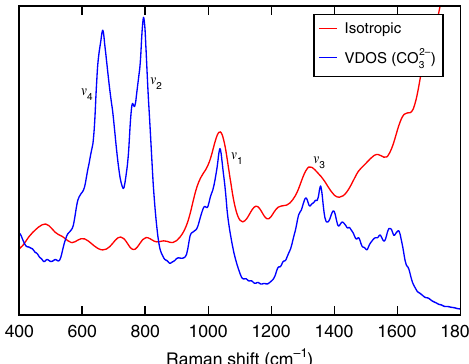
Fig. 6 Raman spectra of the 0.9 molality sodium carbonate solution at ~11 GPa and 1000K. The isotropic Raman spectrum of this solution (red line) and the vibrational density of states (VDOS) (blue line) of CO 2 (cid:1)